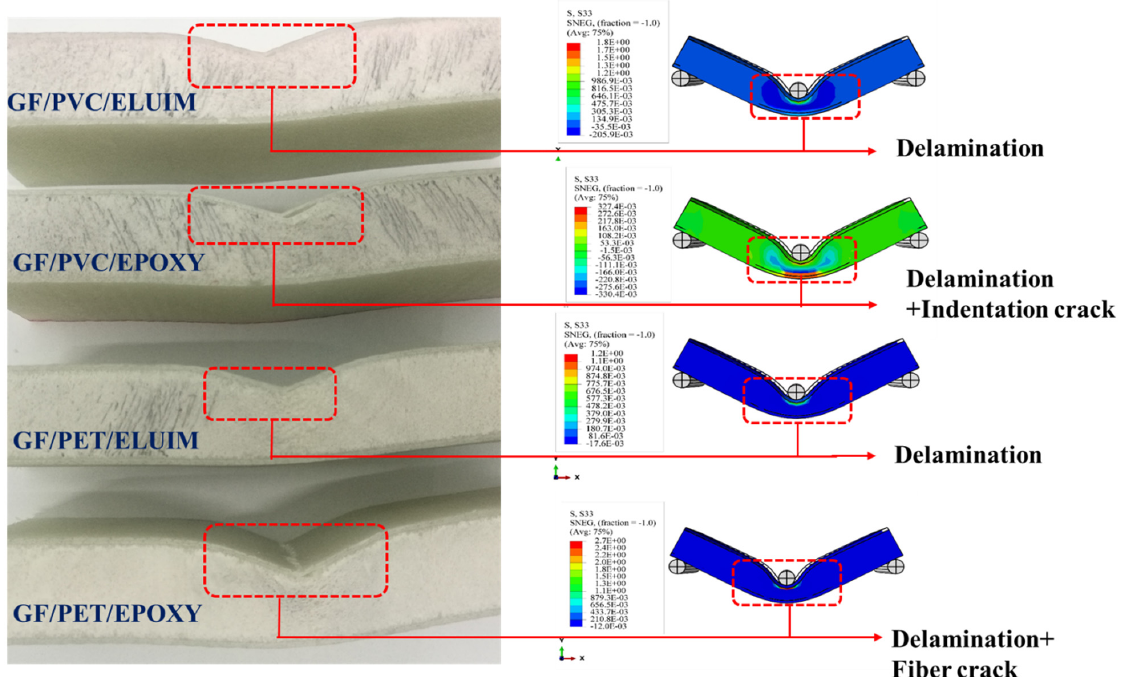
Figure 6. Failure behavior of the sandwich structures with different foams and